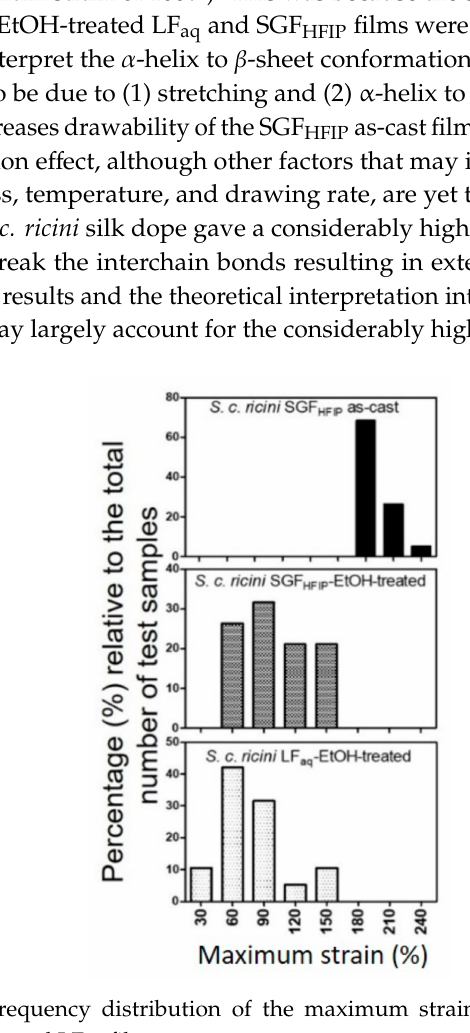
Figure 10. Relative frequency distribution of the maximum strain (%) of the as-cast SGF HFIP , and 80%-EtOH SGF HFIP and LF aq